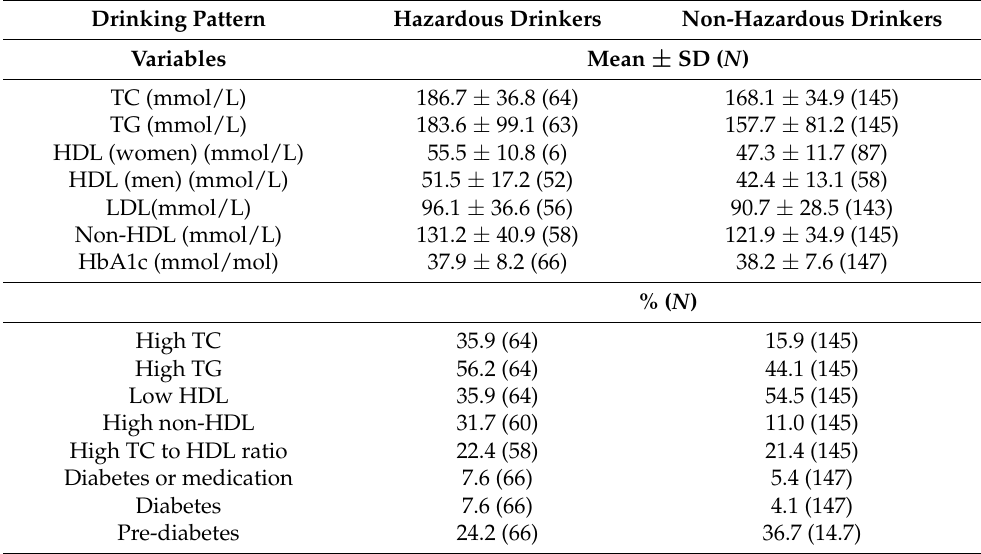
Table A1. Lipid profiles, HbA1c and diabetes related characteristics of the participants by drinking pattern. Drinking Pattern